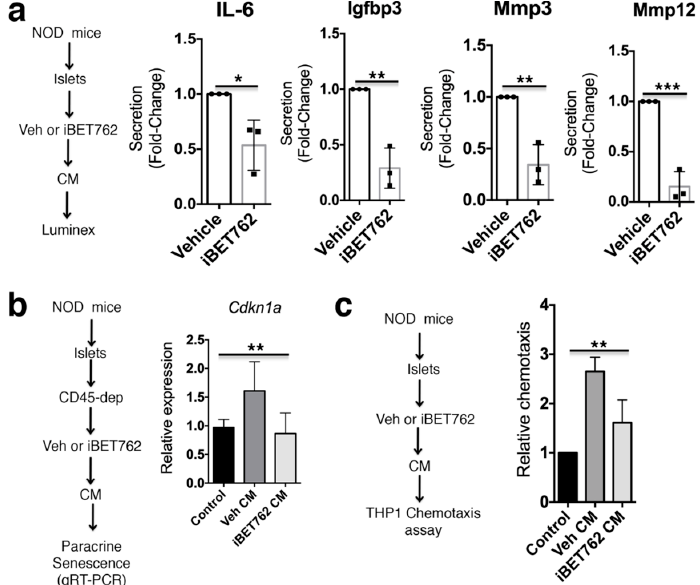
Figure 2. iBET-762 attenuates SASP secretion and paracrine activities from NOD islets. ( a ) Islets isolated from 14-week-old NOD mice were cultured in vehicle or iBET-762 for 24h and the conditioned media (CM) was collected for luminex assays. Relative quantification of average secretion of SASP factors IL-6, Igfbp3, Mmp3, and Mmp12 from iBET-762-treated islets versus vehicle-control islets, n = 3 biological replicates per group. Error bars are SD. * p < 0.05, ** p < 0.005, *** p < 0.0005, two-tailed t -tests. ( b ) Islets isolated from 14-week-old NOD mice were depleted of CD45 + cells and cultured in vehicle or iBET-762 for 24 h and the resulting CM was collected used in paracrine senescence induction assays on islets from three-week-old old NOD mice, where qRT-PCR for Cdkn1a was a readout of paracrine senescence induction. Regular islet media (not conditioned by islets) was used as a negative control to set the baseline. Data are average relative expression levels from n = 5 or 6 biological replicates per group, error bars are SD. ** p < 0.005, one-way analysis of variance (ANOVA). ( c ) CM was collected from islets of 14-week-old NOD mice cultured with vehicle or iBET-762 and used in chemotaxis assays on THP-1 cells. Regular islet media (not conditioned by islets) was used as a negative control to measure the baseline. Data are chemotaxis fold-change, relative to control, from n = 3 biological replicates per group. Error bars are SD. ** p < 0.005, one-way